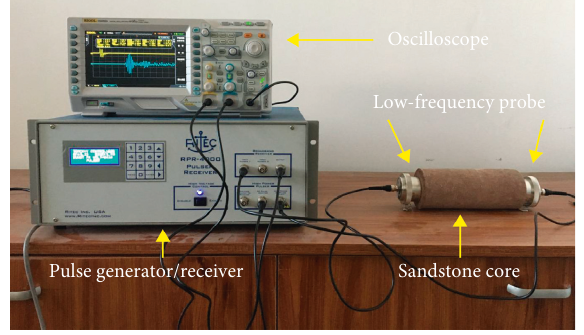
Figure 9: Schematic of the test